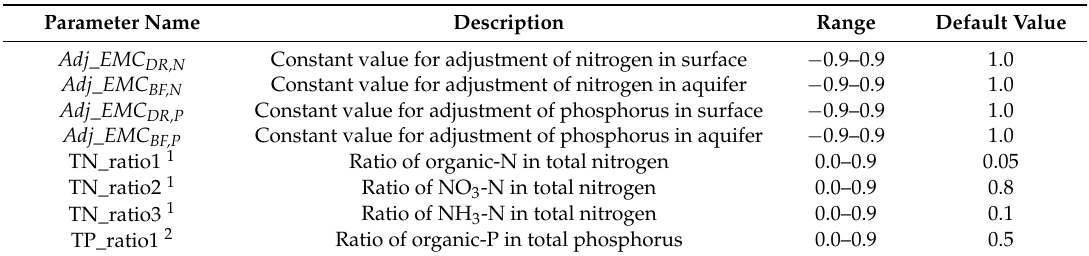
Table 2. Description of event mean concentration ( EMC ), nitrogen, and phosphorus parameters used in instream water quality module.